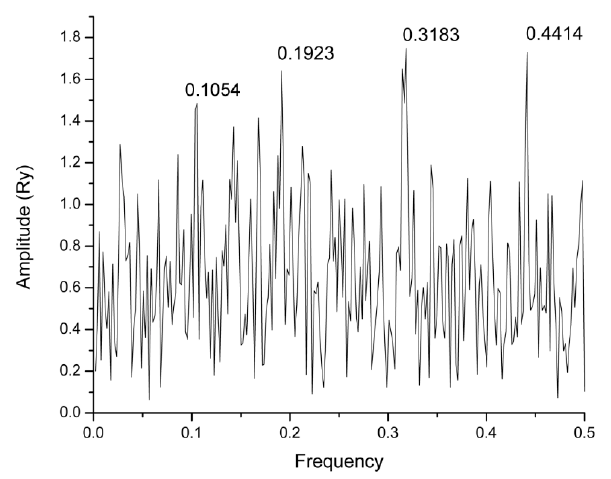
Figure 1. Informational spectrum (IS) of SARS-CoV-2 M pro .